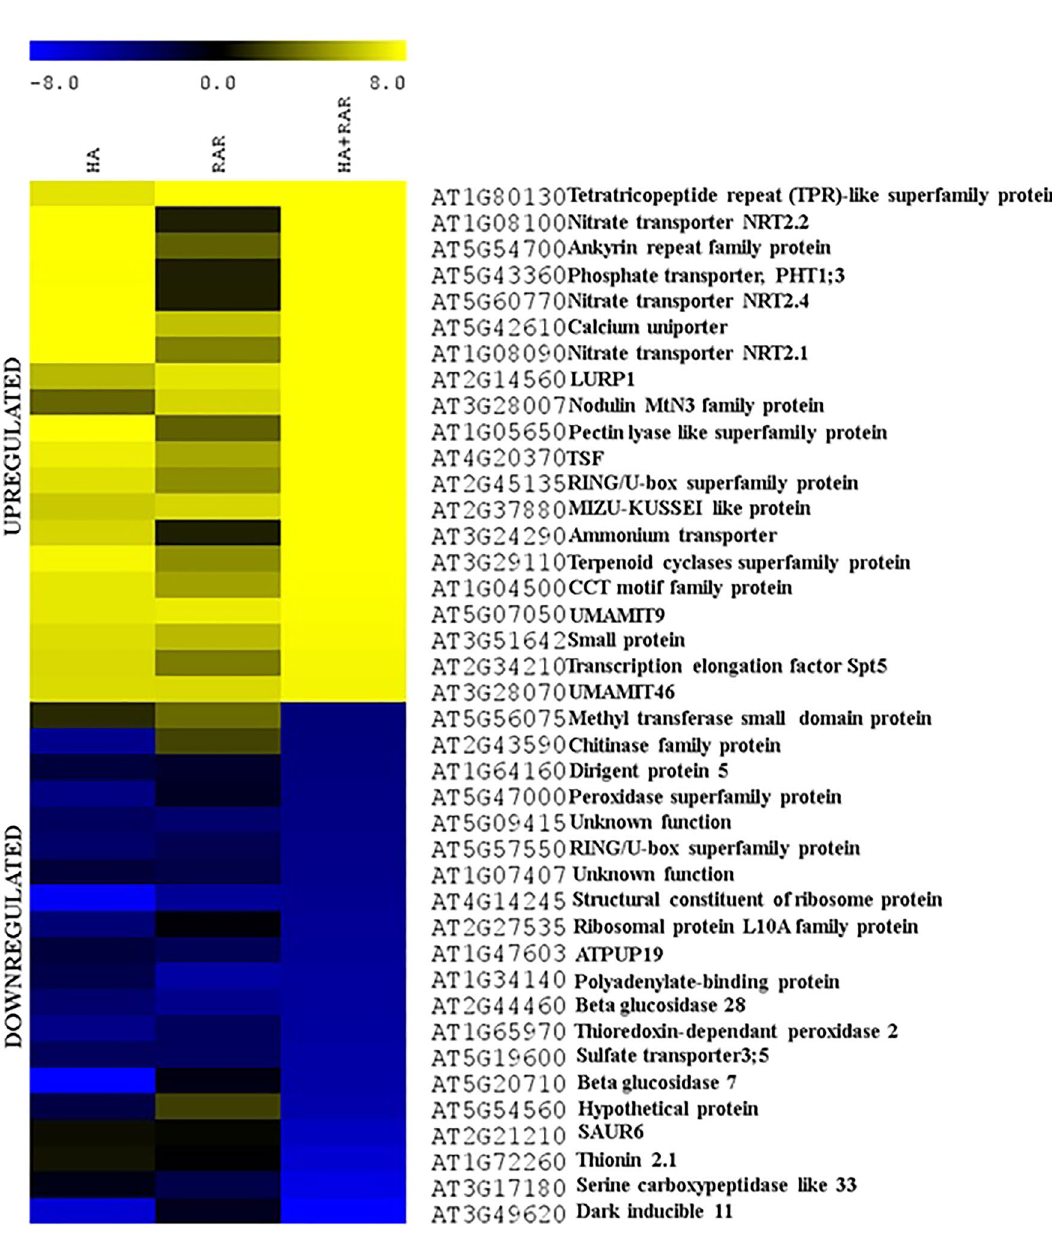
Figure 3. Differential expression of top 20 upregulated and downregulated genes in Arabidopsis thaliana roots grown under phosphate deprived condition in presence of Pseudomonas putida